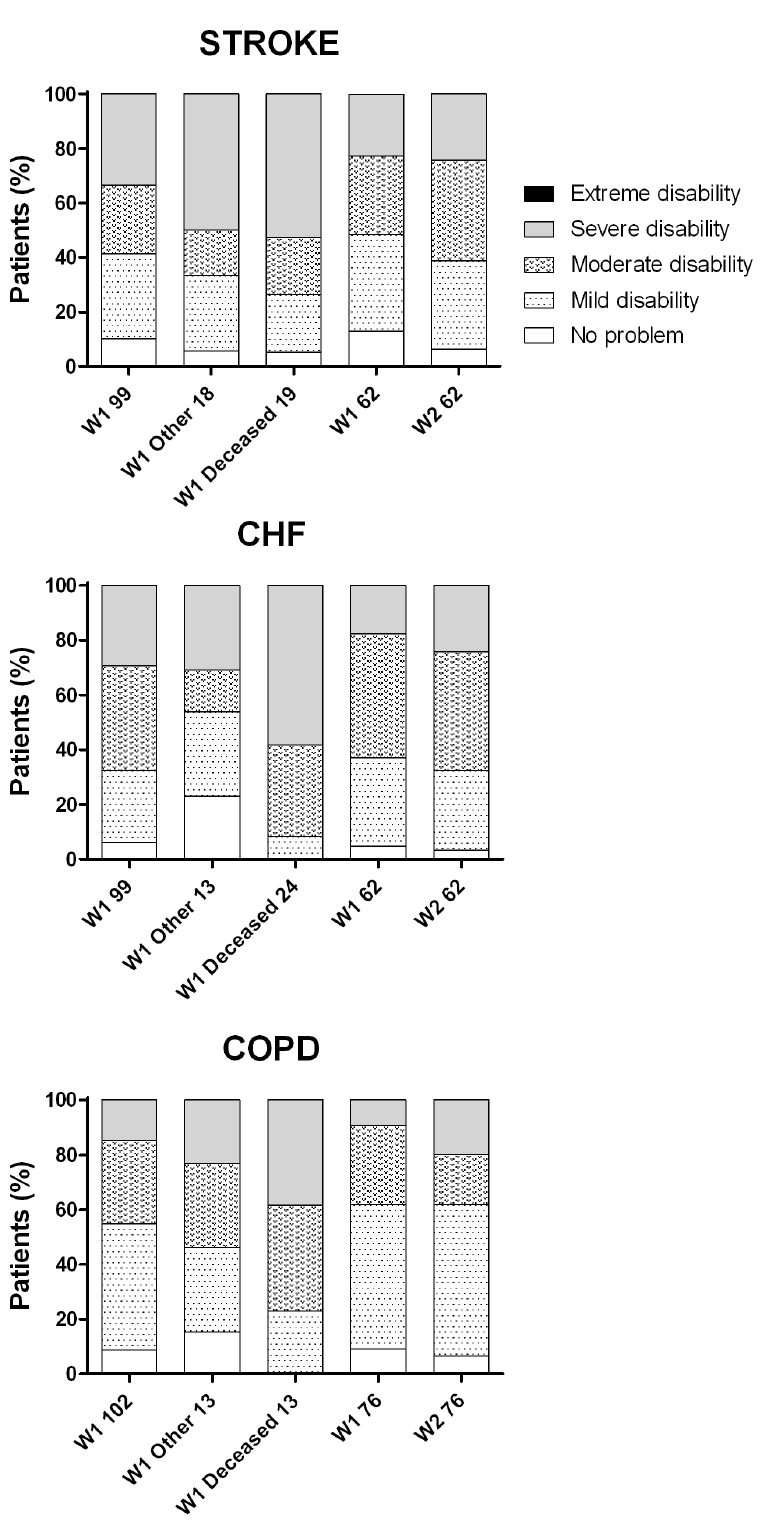
Figure 2. Prevalence of disability categories in three diagnostic groups and several subgroups: all patients at baseline (left); other=non-participants and institutionalised (centre left); deceased during follow-up (centre); and followed-up community-dwelling residents at baseline (centre right) and end of follow-up (right).